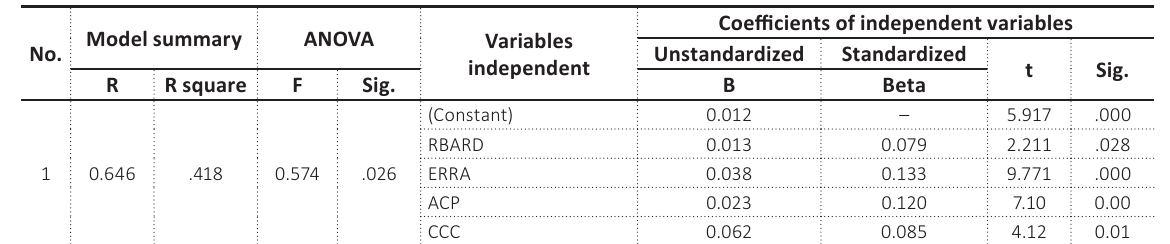
Table 5. Multiple regressions to test credit management